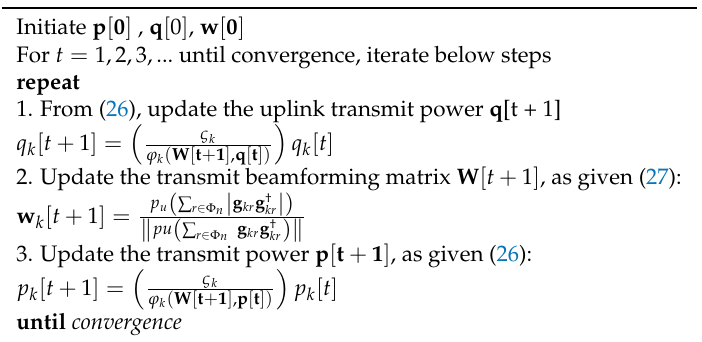
Table 2. Algorithm for Max-Min Weighted SIR for